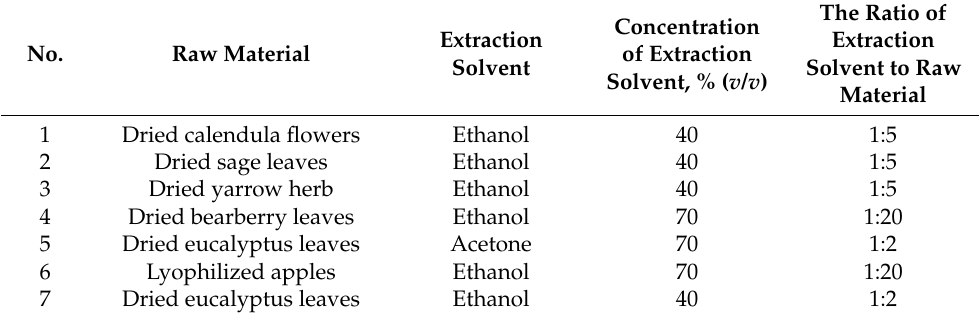
Table 1. Extracts prepared for chemical composition and biological activity